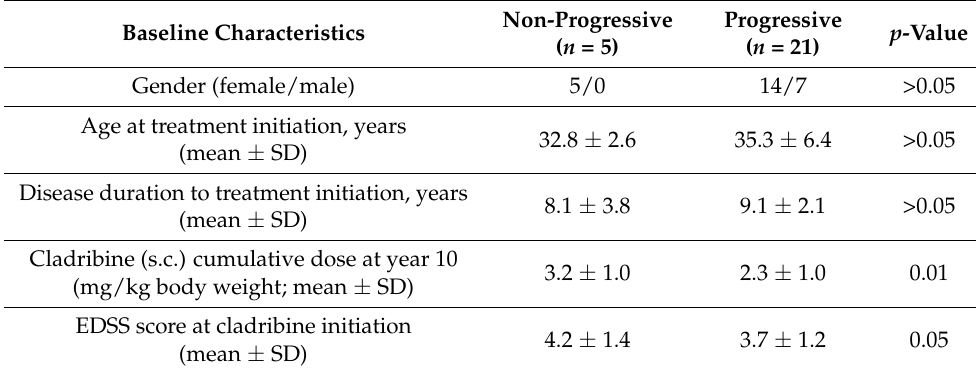
Table 5. Baseline characteristics of progressive and non-progressive patients at year 10, based on analysis of change in EDSS score from year 1 (induction treatment